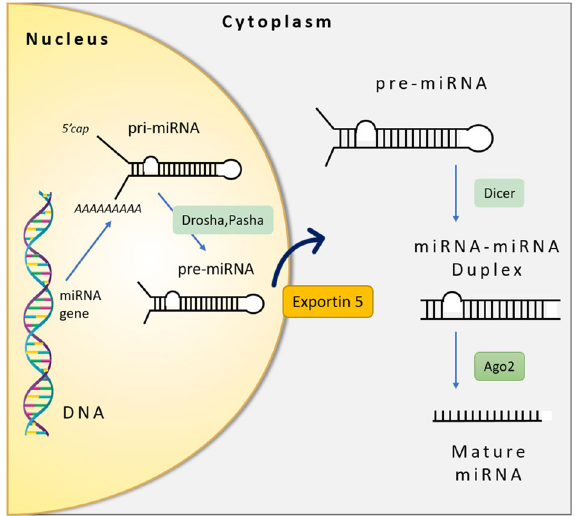
Figure 1. Overview of miRNA